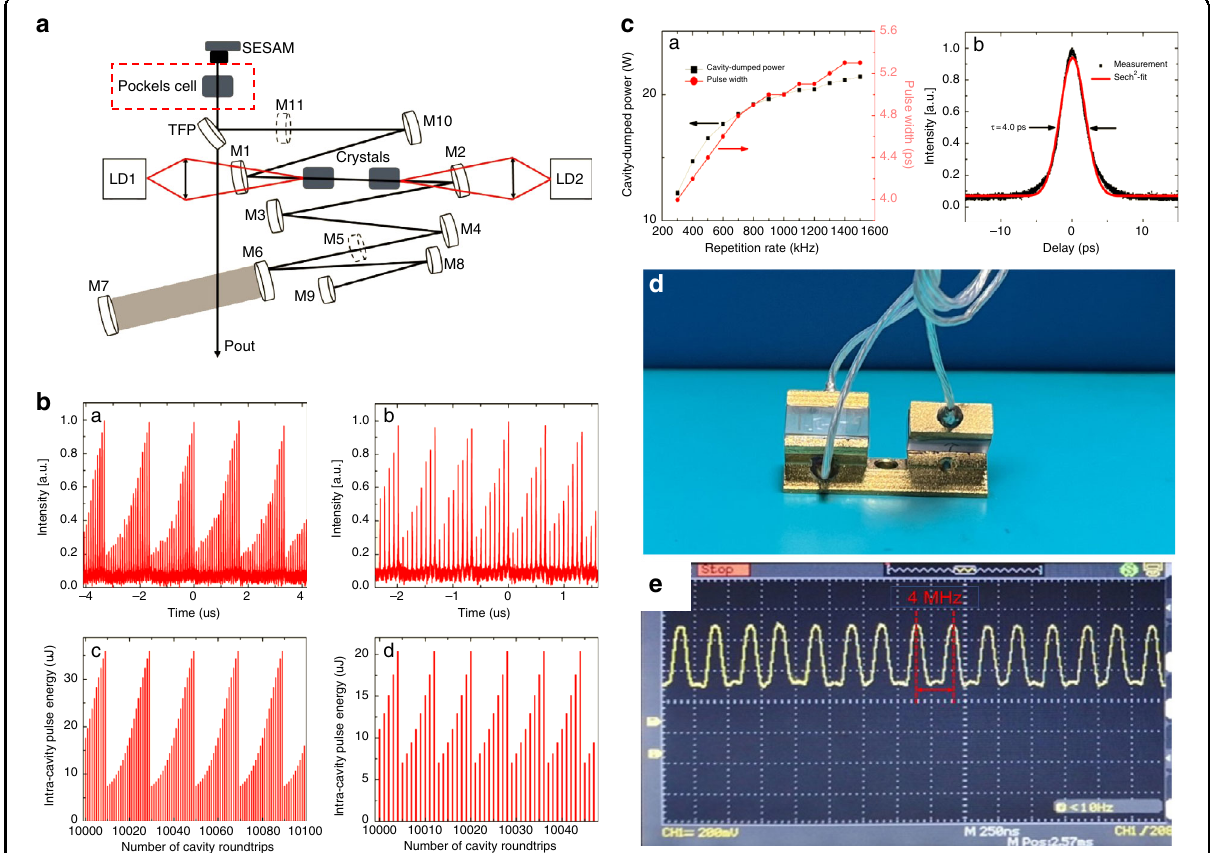
Fig. 13 Selected advances in several KTP EO device applications. a Schematic of the laser cavity with a KTP Pockels cell (PC); b Experimentally formed internal pulse trains with cavity-dumping at repetition rates of: (a) 600 kHz and (b) 1.5 MHz; the corresponding numerical simulations of the intracavity pulse energy at: (c) 600 kHz and (d) 1.5 MHz; c Cavity-dumped power and pulse duration (sech 2 - fi t) versus dumped repetition rates (left); the measured autocorrelation trace at 300 kHz, assuming a sech 2 -shaped pulse (right). Fig a , b , and c reprinted with permission from ref. 99 , © 2015 The Optical Society; d KTP EO modulator with gold-plated electrode holder for enhanced heat dissipation; e Waveform diagram of KTP EO modulator ( d ) at a repetition rate of 4